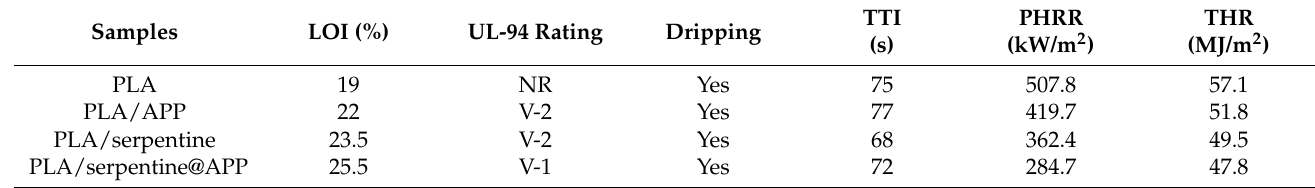
Figure 5. Cone calorimeter tests of pure PLA and its composites. ( a ) HRR, ( b ) THR. Table 3. LOI, UL-94 test, and cone calorimeter data for pure PLA and its composites.